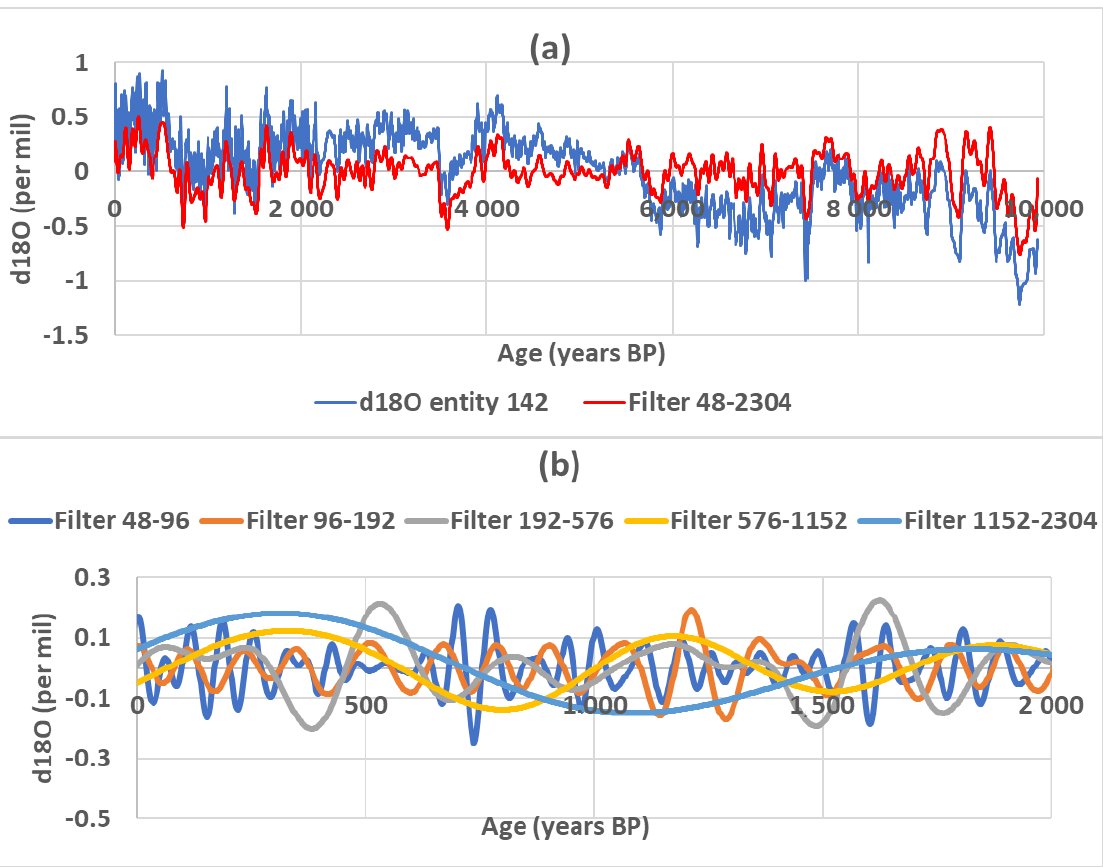
Figure 4. Filtering in subharmonic modes the speleothem (entity 142). ( a ) The raw data and filtered in the broad band 48–576 years; ( b ) speleothems are filtered in the characteristic bands 48–96, 96–192, 192–576, 576–1152, and 1152–2304 years.